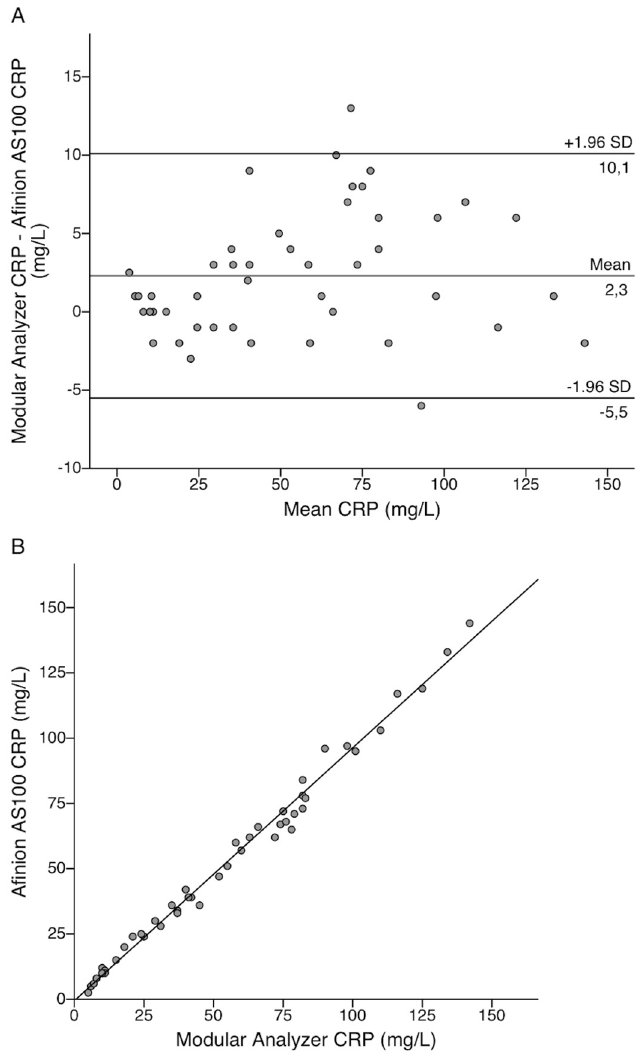
Fig 2. Bland-Altman and linear correlation plots for comparison of CRP methods in the laboratory. Bland-Altman plot presenting level of agreement (A) and a scatterplot showing linear correlation (B) between the Afinion AS100 C-reactive protein (CRP) point-of-care test and Modular CRP results in 48 clinical samples. All testing was performed in plasma samples in the hospital ’ s central laboratory.